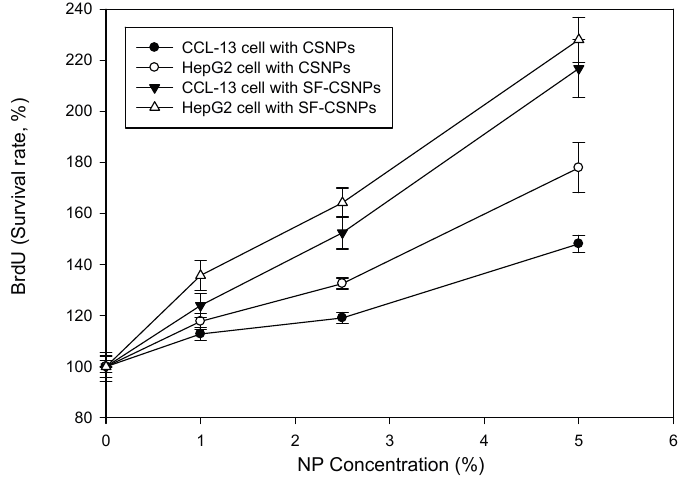
Figure 3. Proliferation (Bromodeoxyuridine (5-bromo-2'-deoxyuridine, BrdU)) test of SF-CSNP and CSNP effects on CCL-13 and HepG2 cells ( n = 6, mean ± standard error, t -test, p <